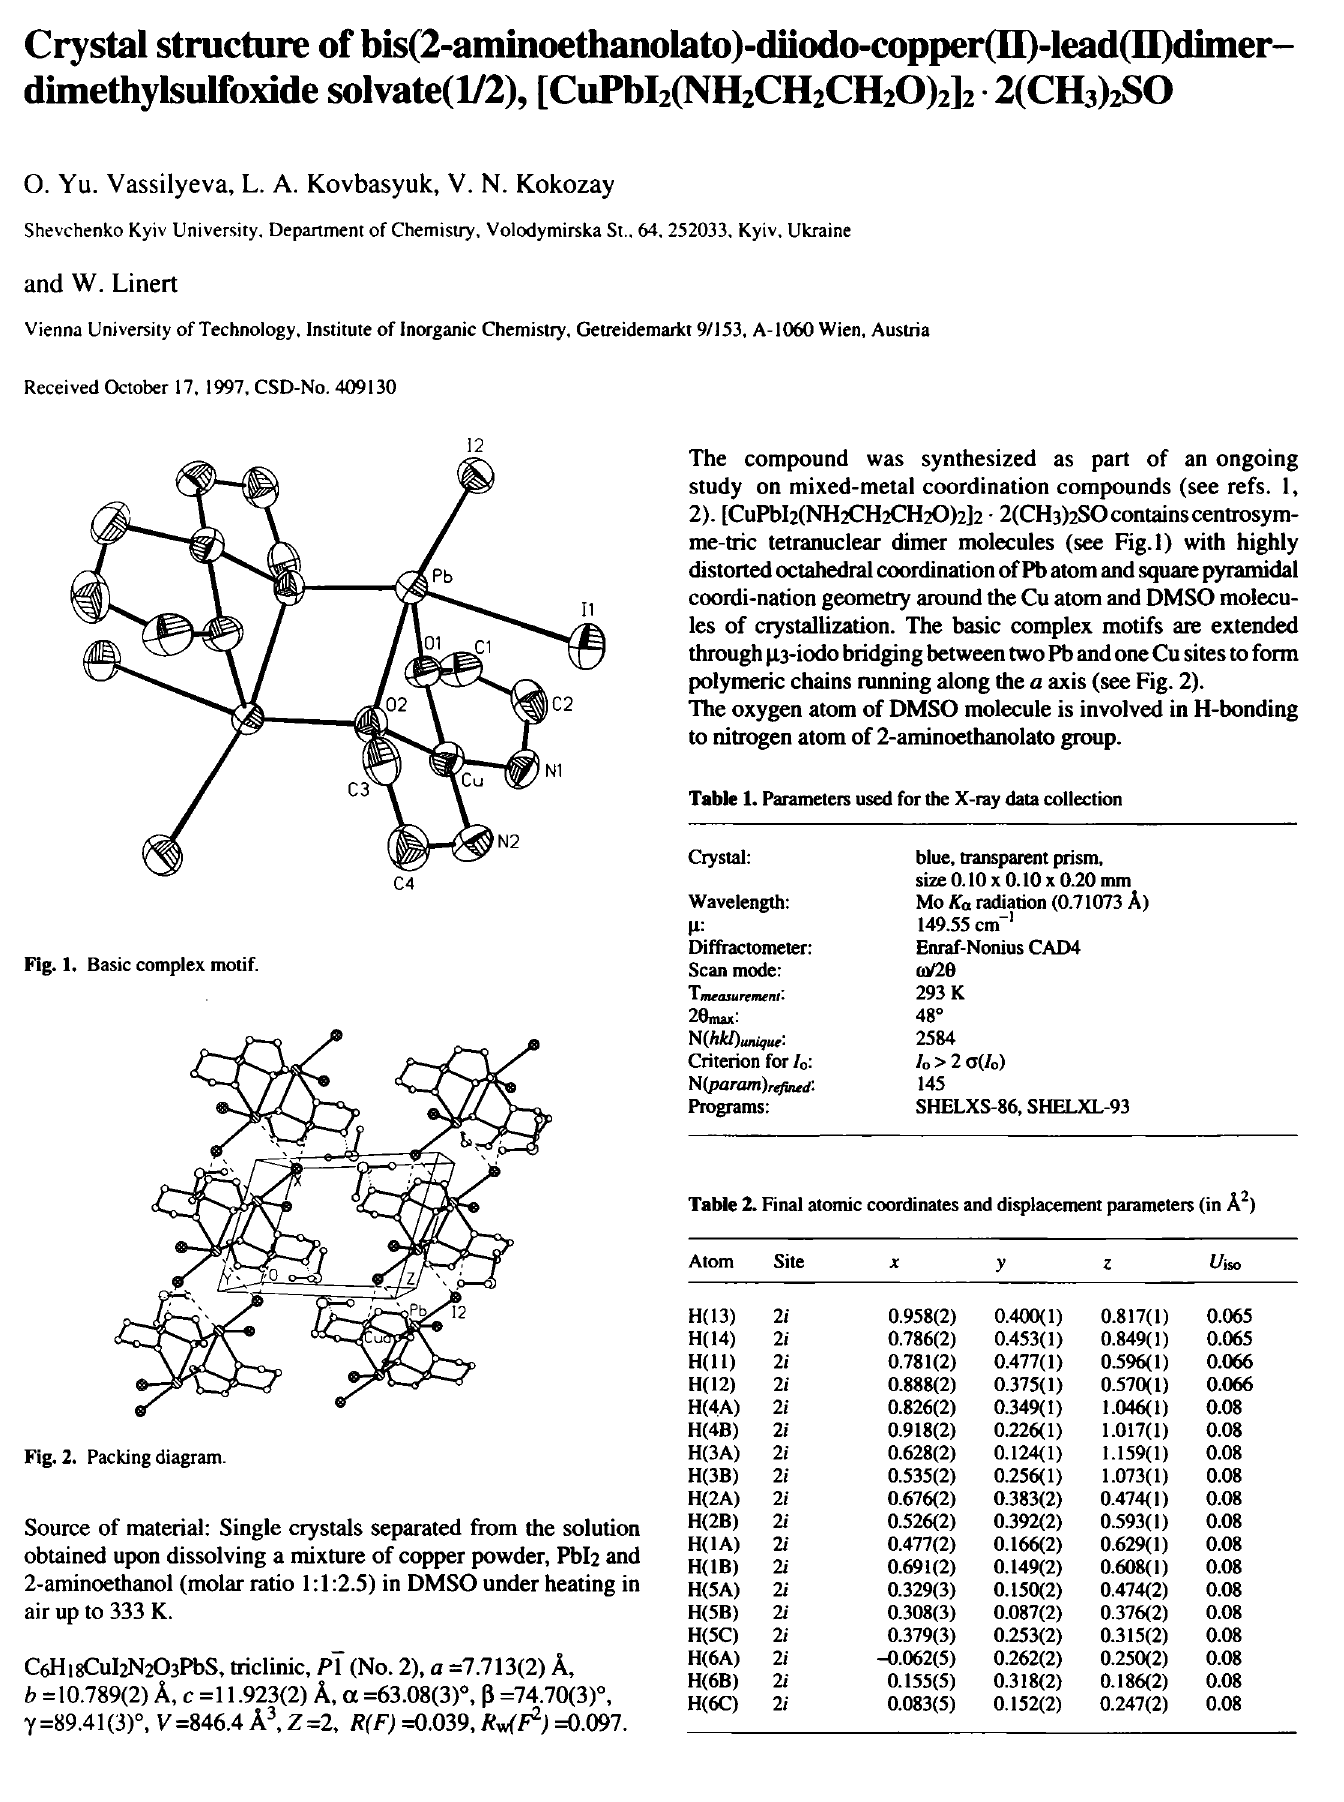
Table 2. Final atomic coordinates and displacement parameters (in